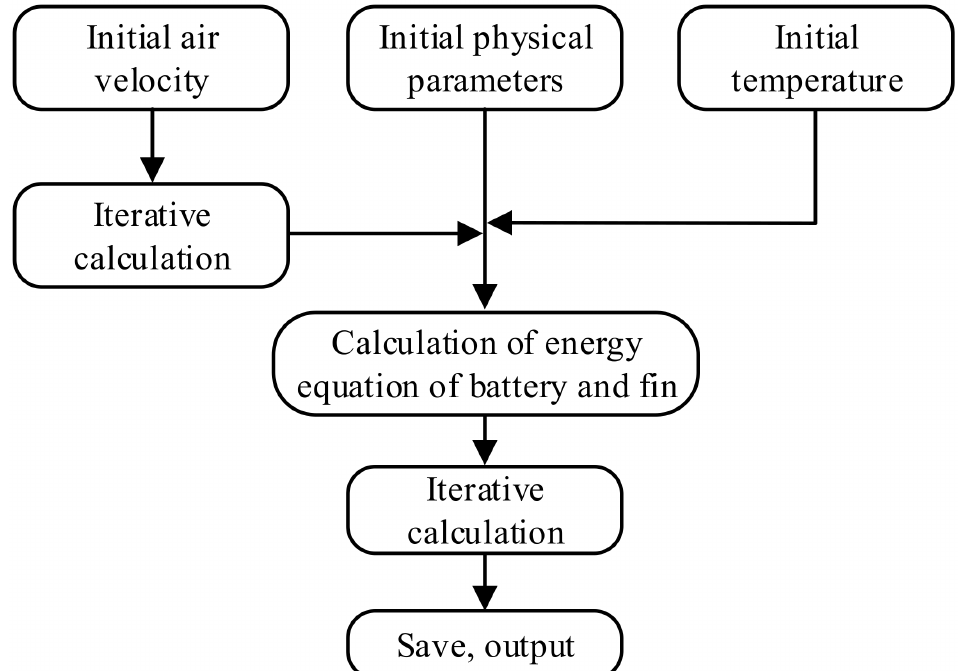
Figure 3. Flow chart of numerical